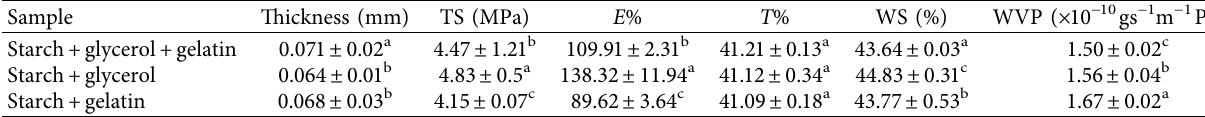
Table 9: The physical performance of the optimized film.